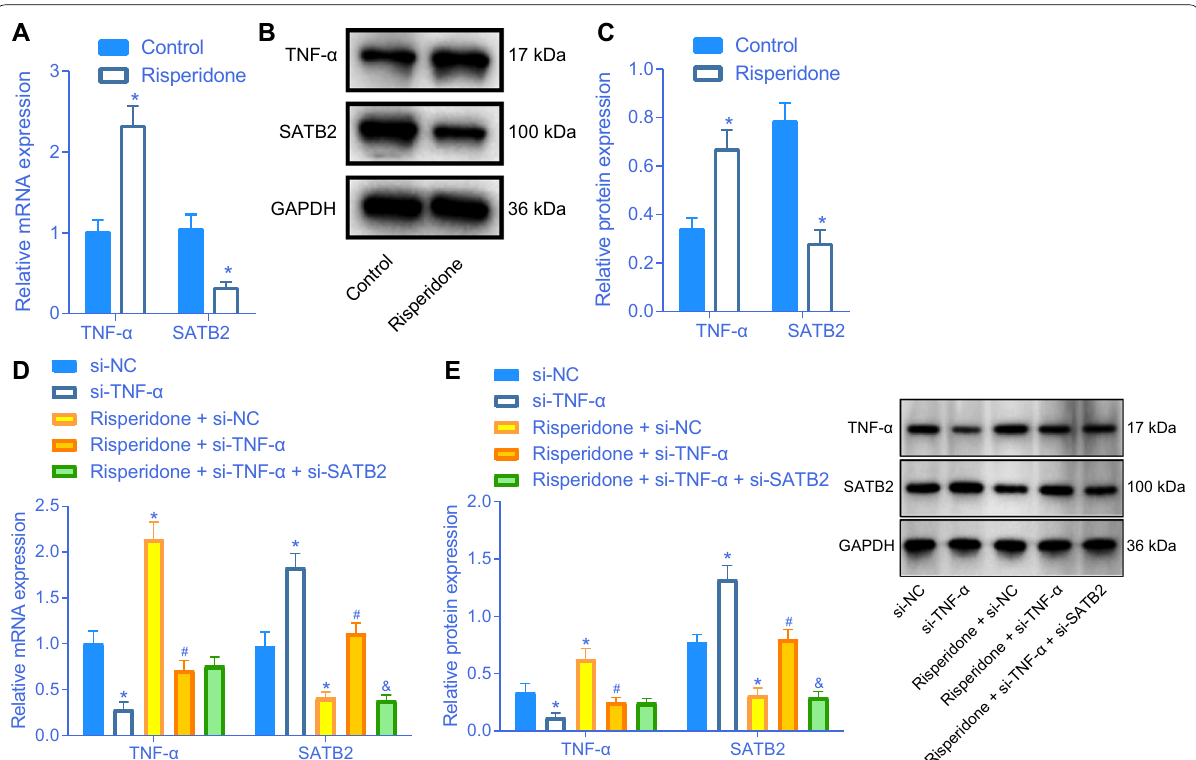
Fig. 4 Risperidone induces an increase of TNF-α expression and a decrease of SATB2 expression. A relative mRNA expression of TNF-α and SATB2 determined by RT-qPCR in control and Risperidone-treated MC3T3-E1 cells. B – C Western blot analysis of TNF-α and SATB2 protein expression in control and Risperidone-treated MC3T3-E1 cells. The band intensity was assessed. D relative mRNA expression of TNF-α and SATB2 was detected by RT-qPCR in MC3T3-E1 cells. E Western blot analysis of TNF-α and SATB2 protein expression in MC3T3-E1 cells. * p < 0.05, compared with control cells or MC3T3-E1 cells treated with si-NC. # p < 0.05, compared with MC3T3-E1 cells treated with Risperidone si-NC. & p < 0.05, compared with MC3T3-E1 + cells treated with Risperidone si-TNF-α. The experiments are repeated 3 +